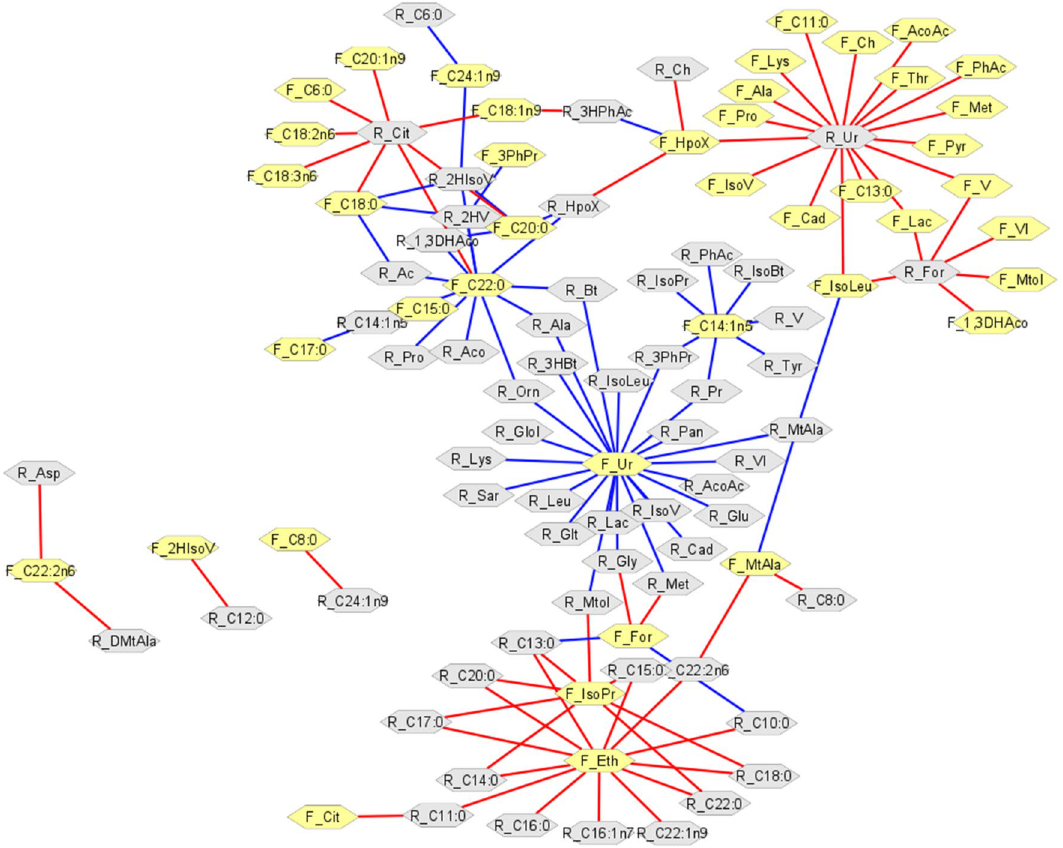
Figure 3. Correlation network between metabolic ruminal and feces profiles in Nelore steers (Spearman’s correlation with P ≤ 0.05), carried out using the Cytoscape software. Gray hexagons represent ruminal fluid metabolites and yellow hexagons, fecal metabolites. Red lines correspond to negative correlations, whereas blue lines correspond to positive correlations between the analyzed bio-samples. The acronyms of each metabolite and correlation coefficient values are presented in Supplementary Table 1,